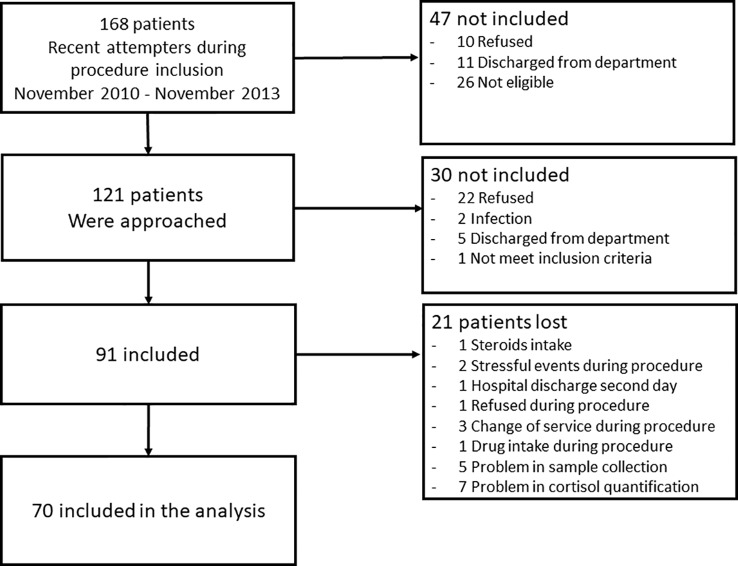
Flow chart of the study recruitment process.